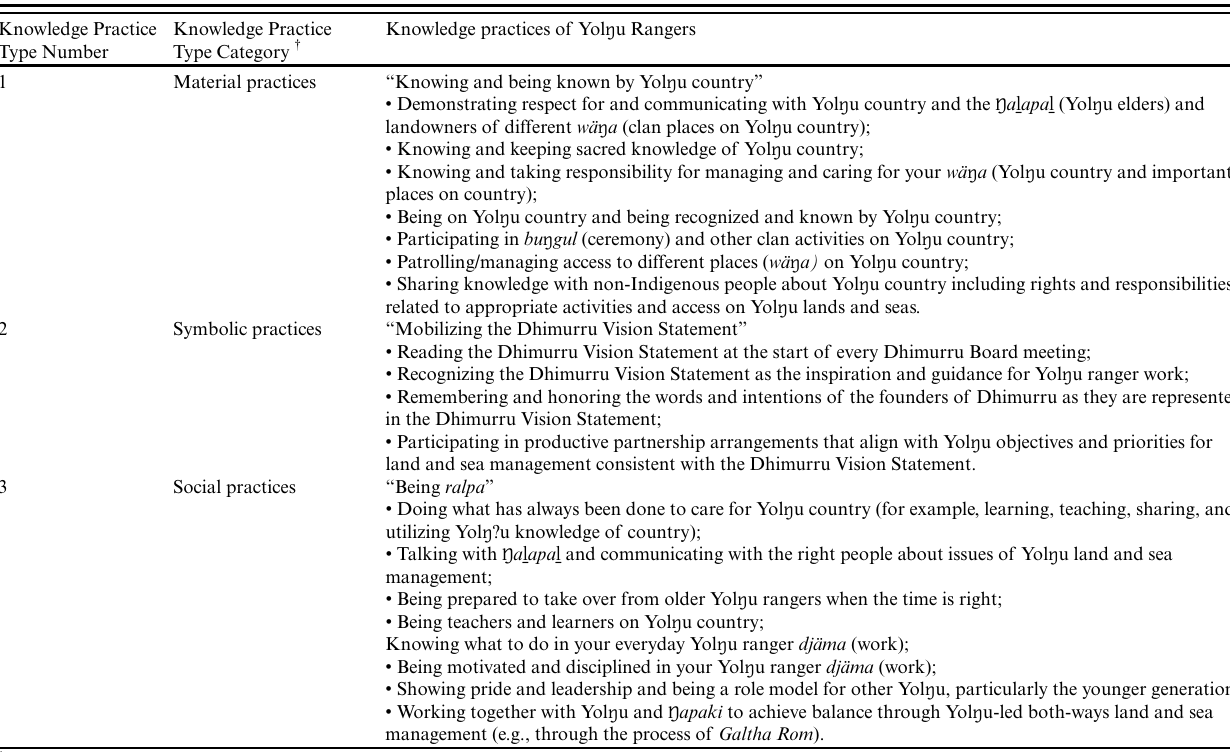
Table 3 . Knowledge practices of Yol ŋ u rangers in the Dhimurru Indigenous Protected